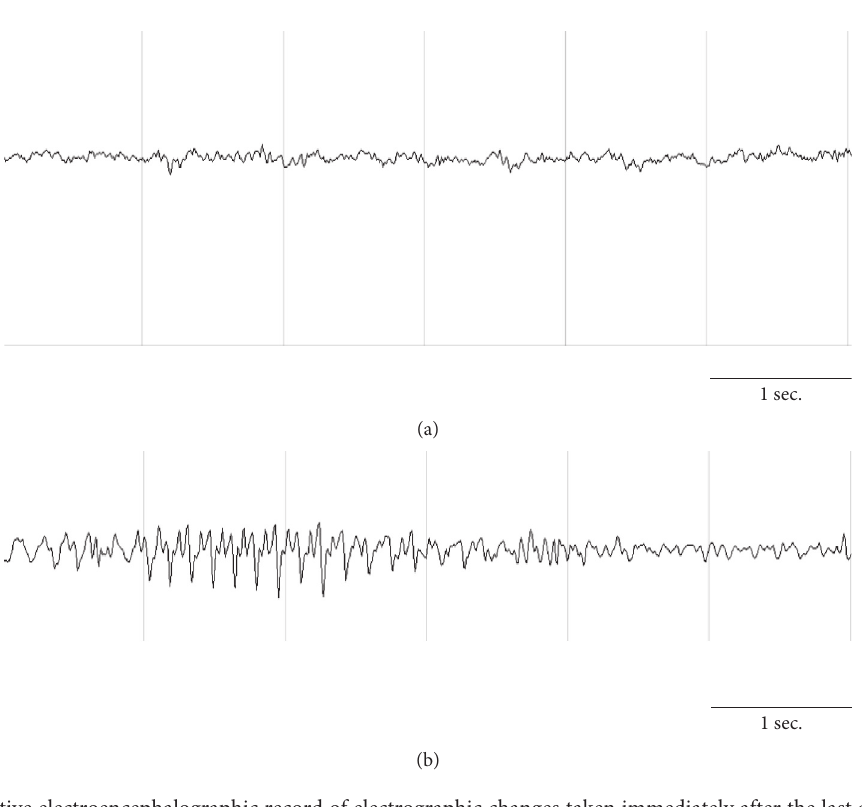
Figure 1: Representative electroencephalographic record of electrographic changes taken immediately after the last administration of the neonicotinoid mixture. (a) Record taken from control rats. (b) Rats administered a neonicotinoid mixture (LD 50 2/10) showing abnormal electrographic activity, characterized by spikes in amplitude and low frequency.